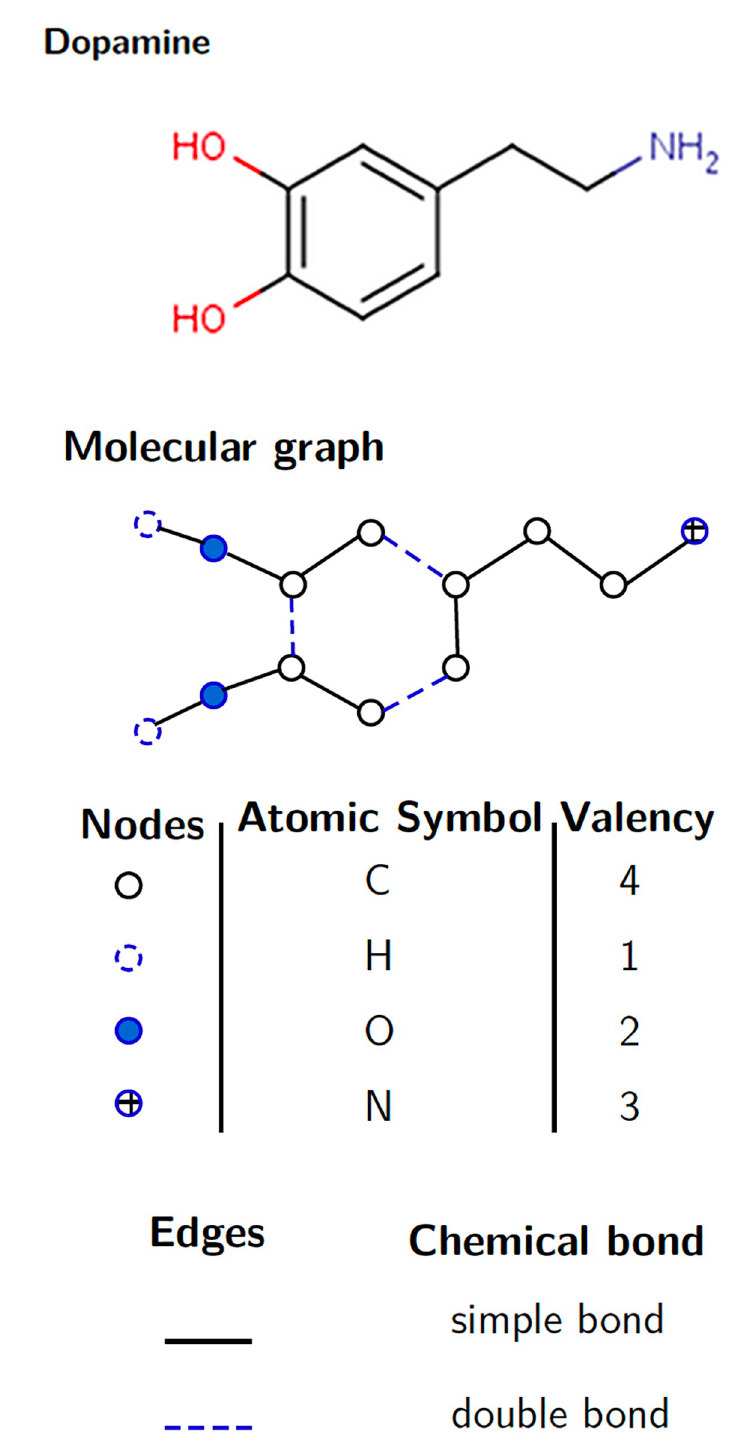
Fig 1. Dopamine and its molecular graph. Different types of nodes according to atomic elements and different types of edges depending on the chemical bond in the molecule.